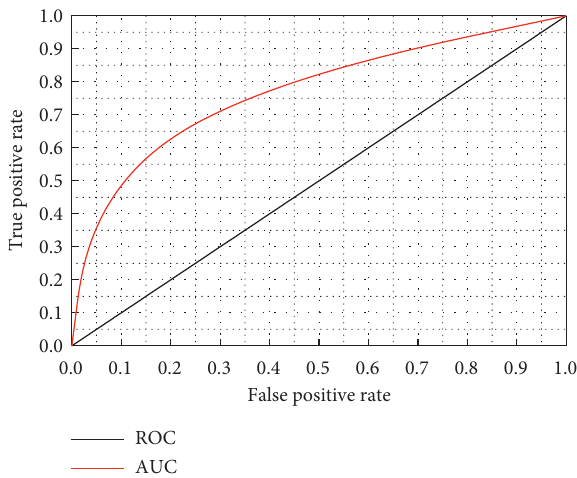
Figure 5: ROC and AUC after decision tree